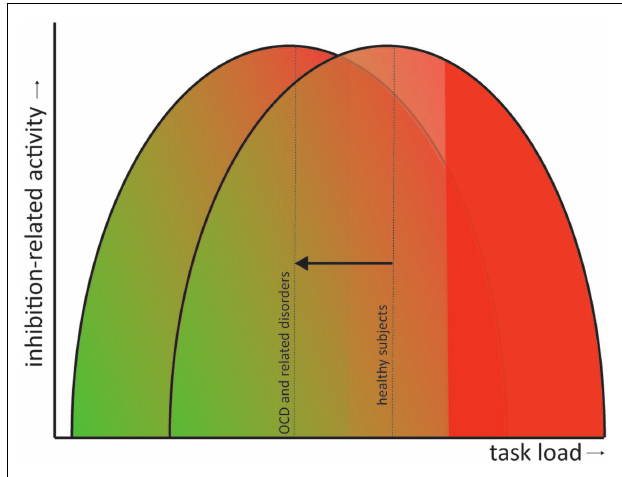
FIGURE 2 | Shift in the inverted U -shaped relation between task load and inhibition-related activity . Inhibition-related neural circuit activity gradually increases with task load (green to red gradient). However, when task demands become too high the compensatory activity starts to fail and behavioral performance becomes impaired (solid red). In obsessive– compulsive and related disorders performance impairments and failure of compensatory neural activation occur at a lower task load than in healthy controls (visualized as a shift of the inverted U -shaped curve to the